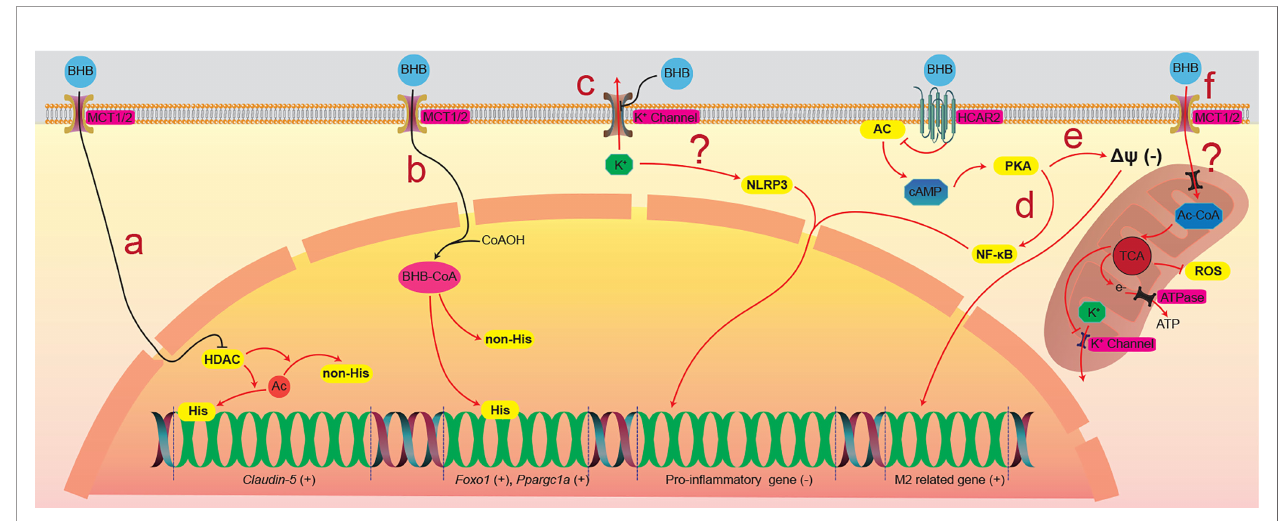
FIGURE 2 | The physiological processes that BHB direct regulates. (A) BHB across the plasma membrane enters the nucleus and inhibits HDACs, which participate in the deacetylation of histone and nonhistone proteins, resulting in the increased expression of the claudin-5 gene in the cardiovascular endothelial cells. (B) BHB that enters the nucleus was activated into acetylated BHB and then b -hydroxybutyrates histone and nonhistone proteins, resulting in the increased expression of Foxo1 and Ppargc1a gene in the CD8 + T cells. (C) BHB holds back the K + channel in the plasma membrane, which maintains the cytoplasmic K + concentration and inhibits the activation of the NLRP3 in fl ammasome. BHB activates HCAR2, a seven-transmembrane G-protein coupled receptor of the Gi family, and inhibits the activity of the AC/ cAMP/PKA signaling pathway. (D) the inhibition of the AC/cAMP/PKA signaling pathway decreases the mitochondrial membrane potential and promotes the transcription of M2-related genes in intrahepatic macrophages. (E) the inhibition of the AC/cAMP/PKA signaling pathway also inhibits the activation of NF- k B, consequently inhibiting the expression of pro-in fl ammatory genes in primary rat microglial cells. (F) the oxidation of BHB in the mitochondrion closes the channel proteins in the mitochondrial intima, which inhibits the out fl ow of ROS. BHB, b -hydroxybutyrate; BHBtion, b -hydroxybutyration; MCT, monocarboxylate transporter; HCAR2, hydroxycarboxylic acid receptor 2; HDACs, histone deacetylases; Ac, acetyl group; His/non-His, histone/nonhistone proteins; AC, adenylate cyclase; cAMP, cyclic adenosine monophosphate; PKA, protein kinase A; NF- k B, nuclear factor kappa-B; Ac-CoA, acetyl coenzyme A; TCA, tricarboxylic acid cycle; ROS, reactive oxygen species; ATP, adenosine triphosphate; ATPase, ATP synthase.